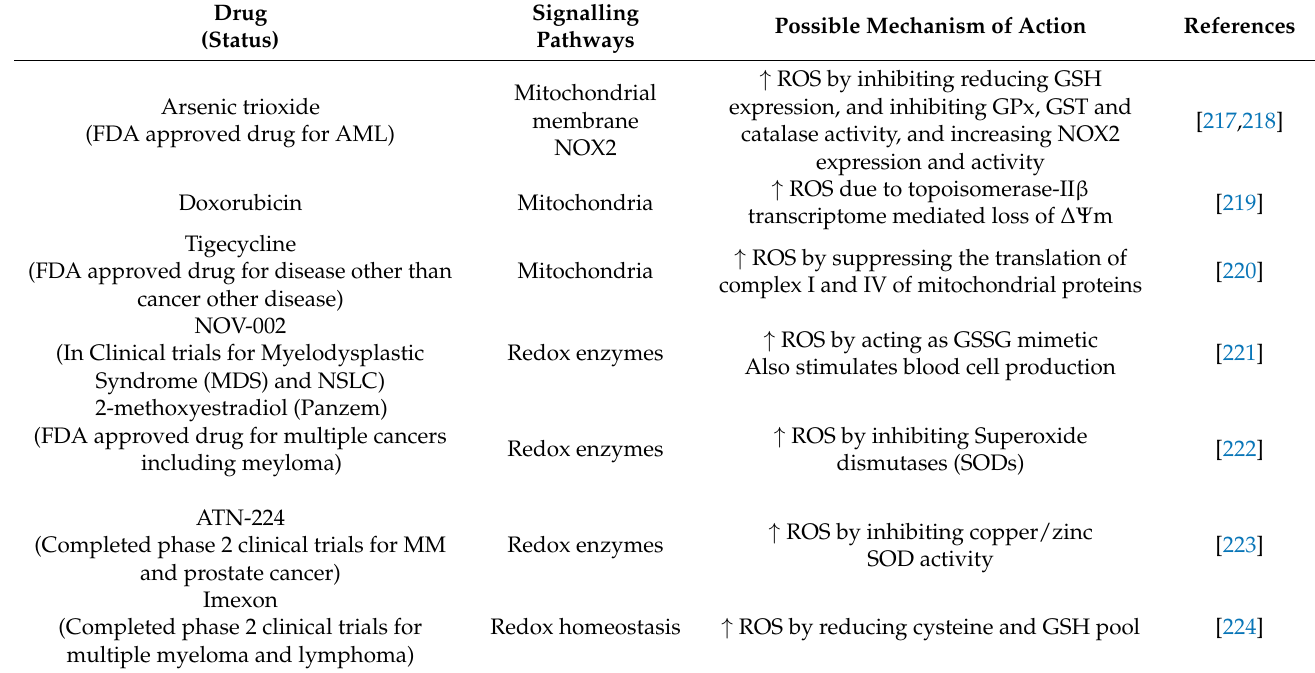
Figure 2. Pro-oxidant therapies for the treatment of acute lymphoblastic leukaemia. Pro-oxidant therapies such as chemotherapies cause redox dysfunction driving irreversible genotoxic stress and are linked to increased activity of NOX proteins. Mitocans target the mitochondrial electron transport chain, increase the permeability of mitochondrial membranes, increasing cytoplasmic ROS. High-level ROS production increases expression and activity of pro-apoptotic proteins such as p53 and caspases, inducing cell cycle arrest, releasing cytochrome c and inducing apoptosis in leukaemic cells. The molecular targets and mechanisms of drugs enhancing ROS production are listed in Table 1. Red shapes = proteins with increased activity or expression; lightning bolt = proteins harbouring mutations/translocations; orange = oxidised proteins; light green = reduced proteins. Table 1. Pro-oxidant therapies used in the pre-clinical models of various